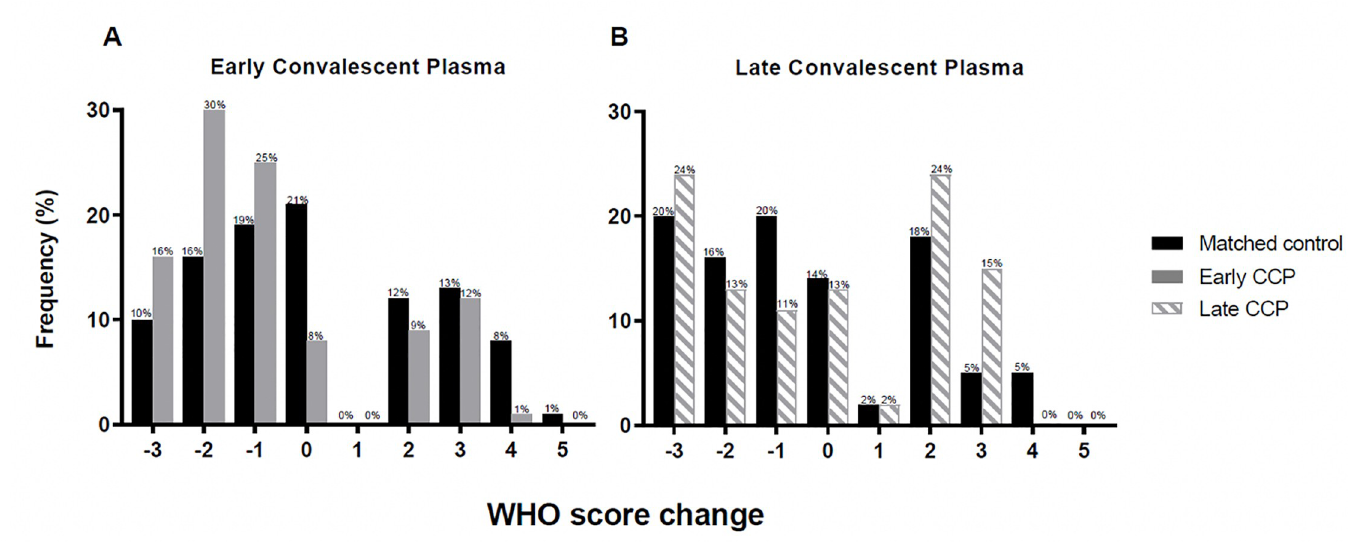
Fig 3. Histogram plots of WHO ordinal scale scores before and after intervention in the early (A) and late CCP (B) compared to matched unexposed cohorts. Shown is a histogram of the change is WHO COVID-19 severity score from time of index to discharge in (A) early CCP recipients (gray solid bars) vs matched unexposed patients (black solid bars) (B) late CCP recipients (gray dashed bars) vs matched unexposed patients (black solid bars). WHO scores in (A) early CCP recipients were significantly improved at discharge (difference in mean -0.9, [95% CI -1.5 to -0.3]; p = 0.004) when compared to unexposed patients. Relative to the unexposed patients, early CCP recipients were nearly twice as likely to demonstrate an improvement in their WHO scores at discharge from baseline index day scores (OR 1.9,[95% CI 1.1 to 3.3]; p = 0.02). Among (B) late CCP recipients, there was no effect of CCP on WHO scores at discharge (difference in mean +0.6, [95% CI -0.4 to 1.5]; p = 0.23). The odds ratio for improvement at discharge was 0.6 (95% CI 0.3 to 1.3; p = 0.22).